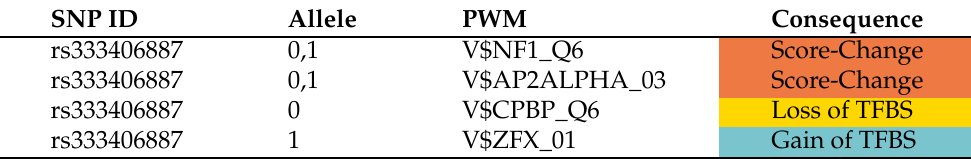
Table 6. Consequences of the SNP rs333406887 (C/G) located -238 bp from the porcine APOA2 TSS. Allele 0 refers to a predicted TFBS in the reference sequence, while allele 1 stands for the alternate allele. A SNP causes a loss or gain of TFBS if the considered TFBS is only predicted for the reference or alternate allele, respectively. A SNP is considered to cause a score-change if the TFBS is predicted on both alleles (0,1) with a difference in the matrix similarity score computed by MATCH™